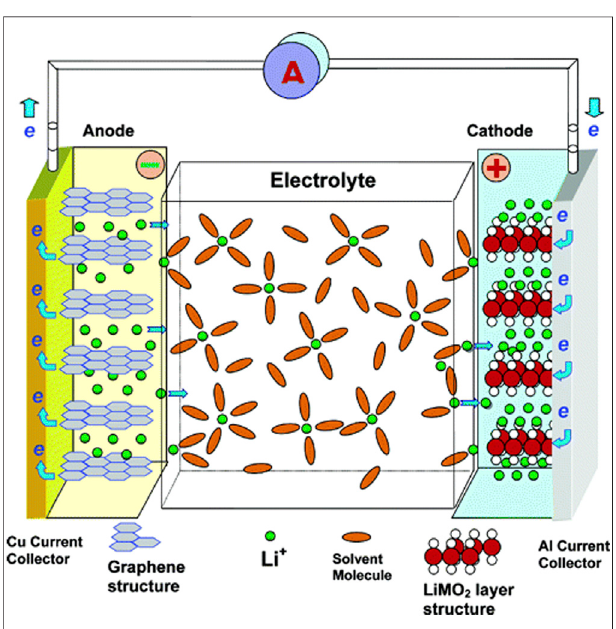
FIGURE 8 | Schematic representations of a lithium-ion battery (in dischargemodeofoperation) (reprinted withpermission from(Xuetal.,2004).